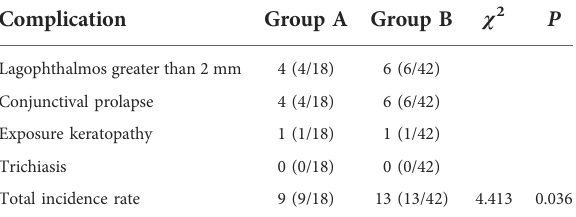
TABLE 3 Comparison of postoperative complications between two groups.